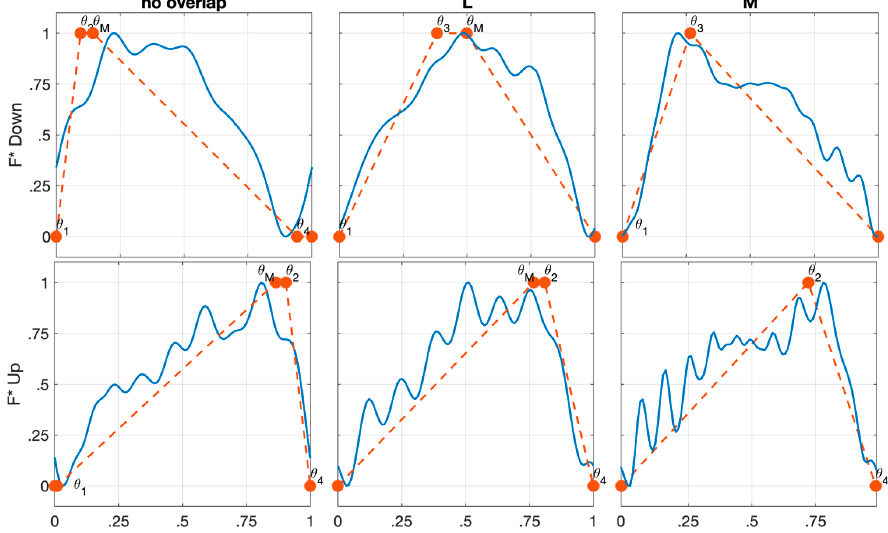
Figure 11. Type III normalized F shapes (tests 27 to 29 in down-milling; tests 30 to 32 in up-milling).